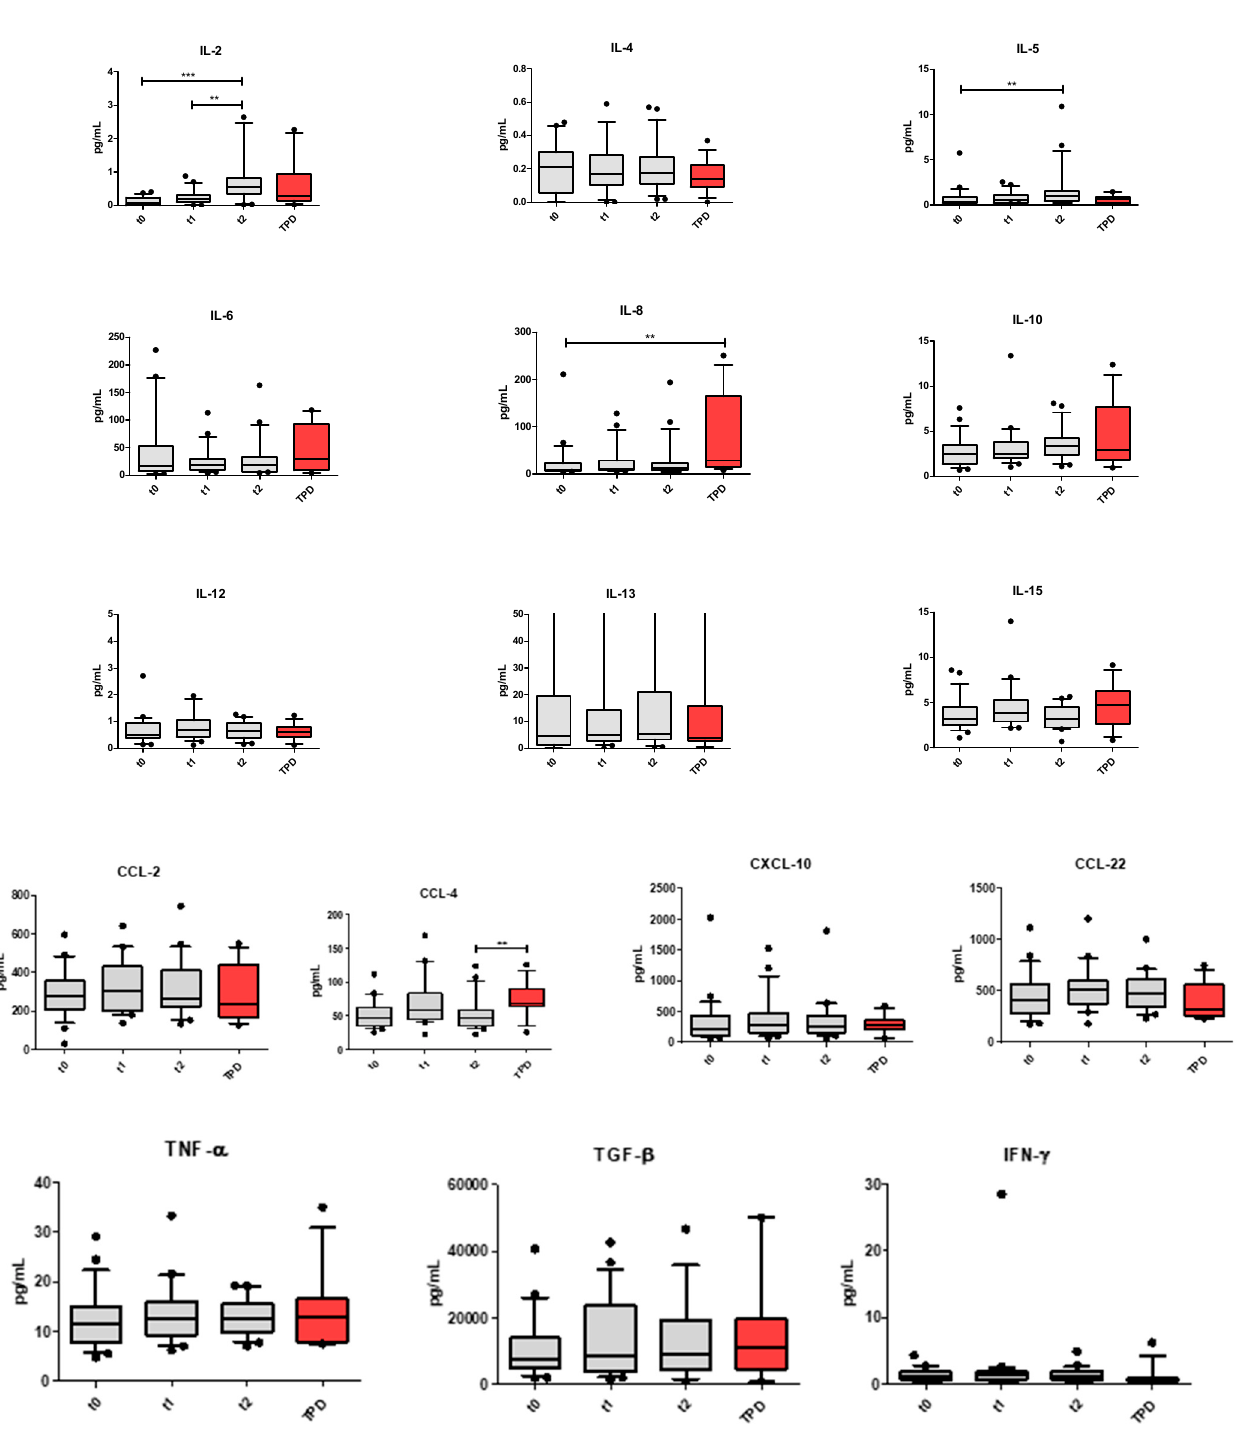
Figure 8. Distributions of five cytokines in group A (blue bars) and B (green bars). Only cytokines with any statistical significance or trend are shown. Concentrations are express in pg/mL. IL-2 for graphical purpose has a value (84.60 pg/mL) at t2 of group A that was intentionally removed by scaling the y-axis. * p ≤ 0.05; *** p ≤ 0.001.